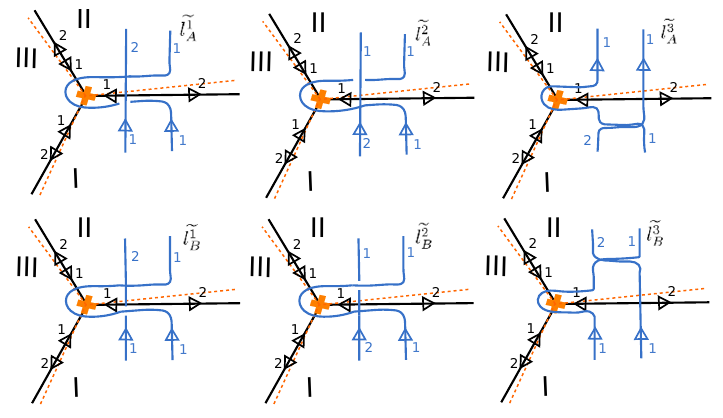
Figure 57 . Three lifts of l A and l B making the same total